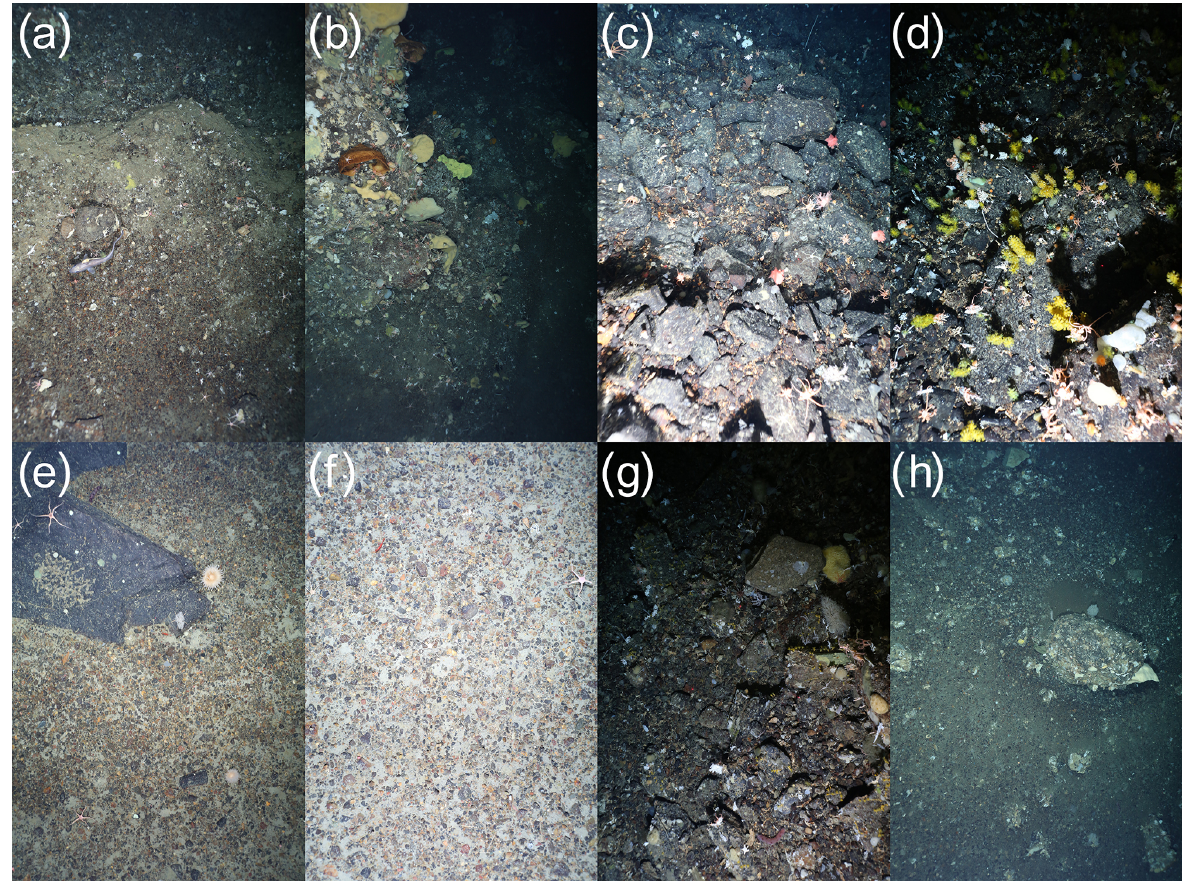
Figure 4. Typical seafloor and cliff escarpment images collected during OFOBS surveys of the Powell Basin flanks during RV